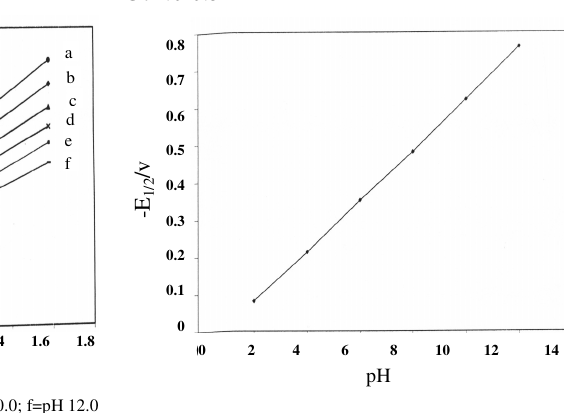
Figure 5 . i vs h 1/2 plots of fluchloralin d Con.0 0.5 mM